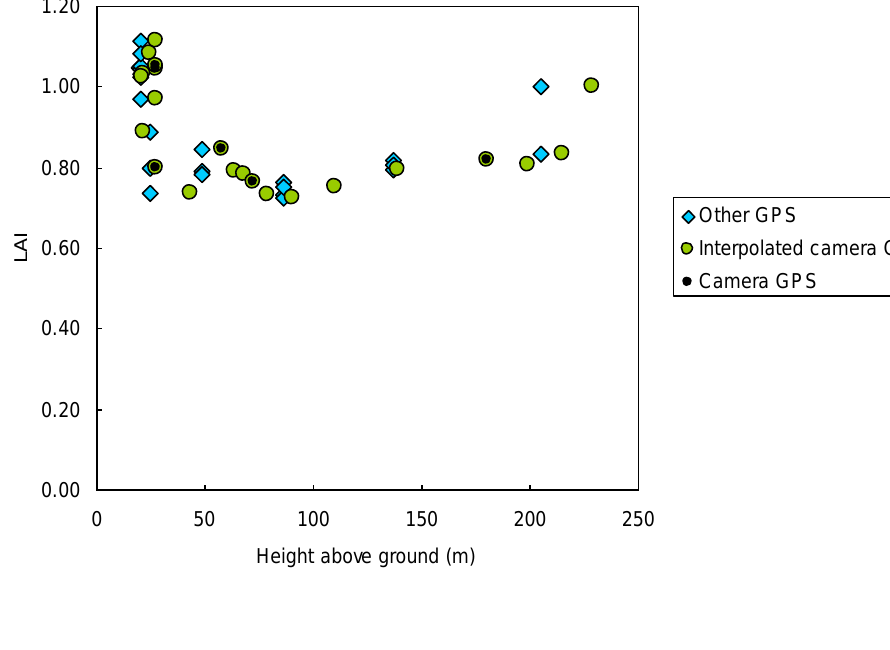
Figure 6. The airborne LAI profile corresponding to Figure